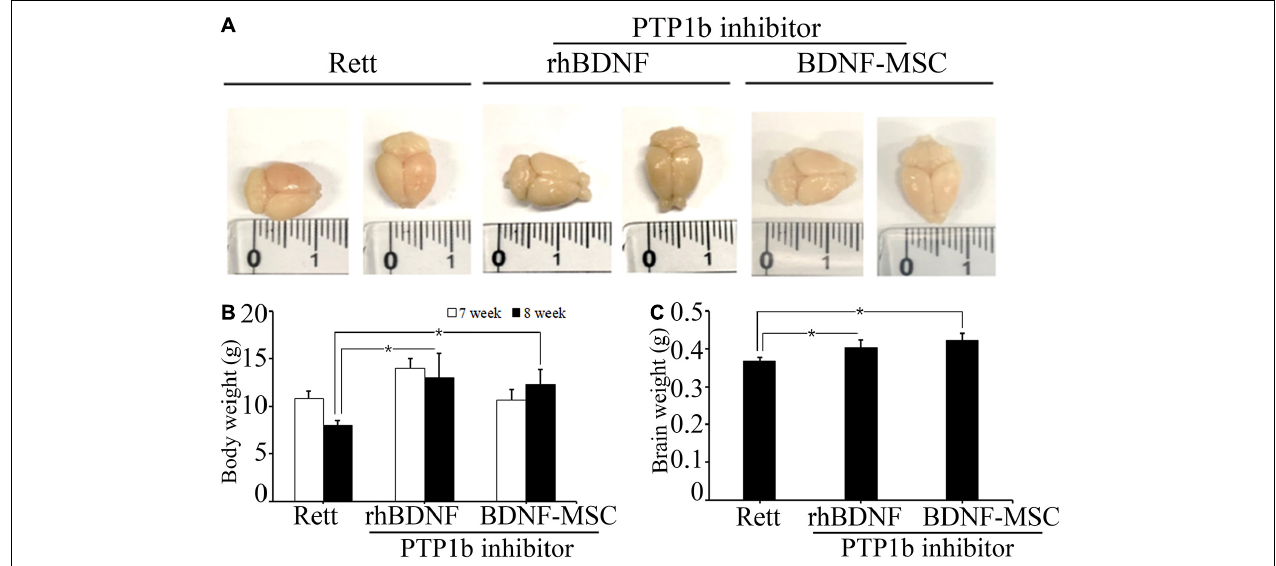
FIGURE 4 | Comparison of body and brain weights. (A) Stereotaxic surgery was performed at 7 weeks and brain samples were collected at 8 weeks of age. Brain size was measured after fixation with 4% PFA. (B) The average body weights of the animals at 7 and 8 weeks of age. (C) Brain weight represented in a bar graph. * p <